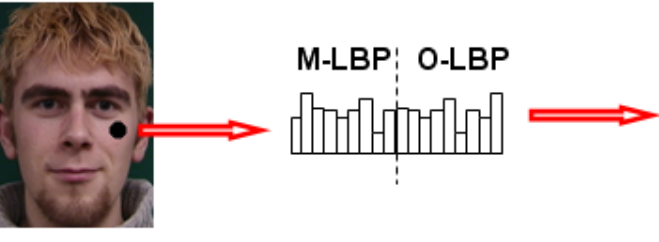
Figure 6. The multi-mode LBP feature extraction and encoding.